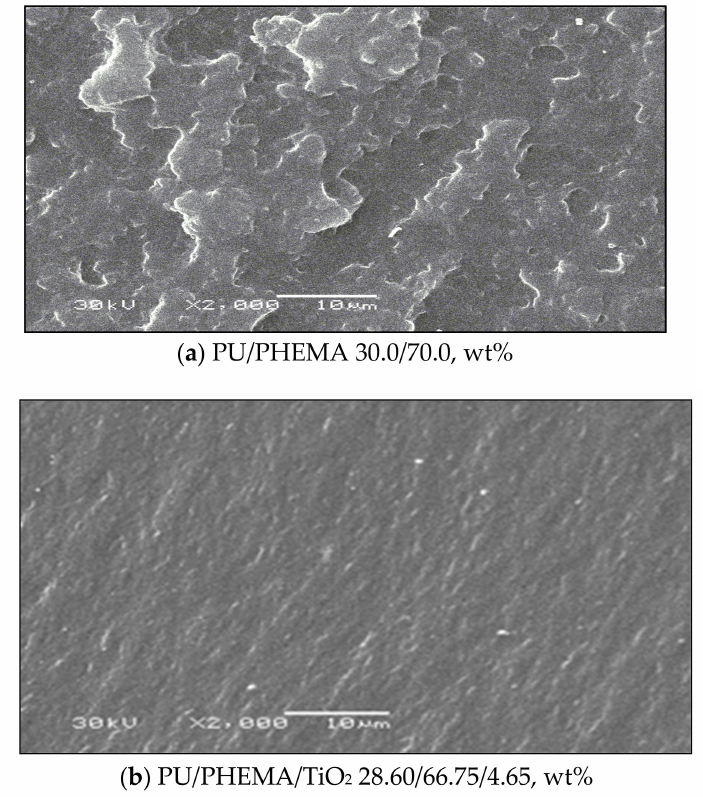
Figure 6. SEM images of transverse cleavages of IPNs ( a ) and OI IPNs ( b )